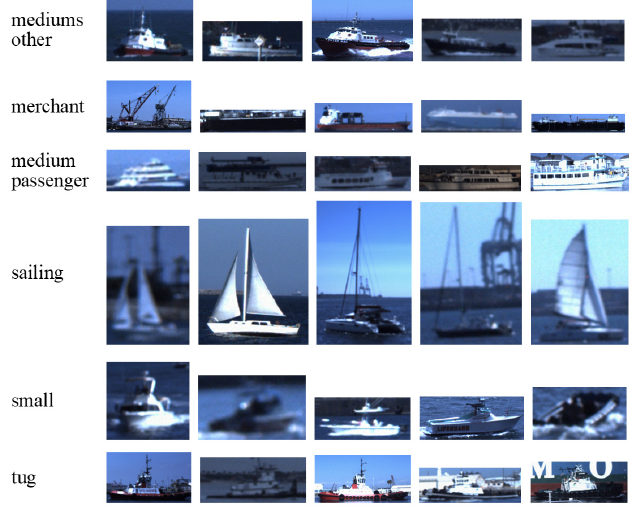
Figure 14. Five visible samples from each of the main classes of the VAIS dataset. Table 6. Number of training and test samples using the VAIS dataset.